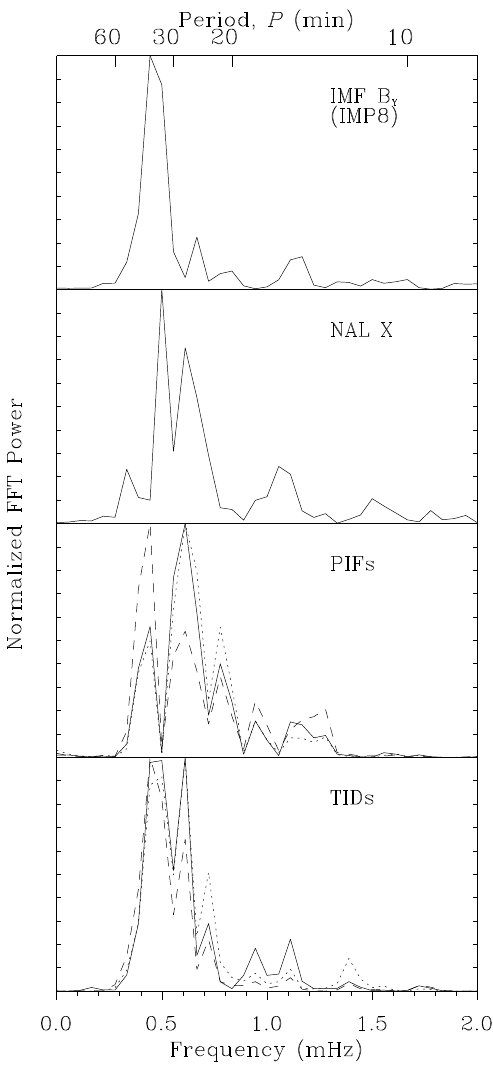
Fig. 13. Comparison of normalized spectra of the ground magnetic field X component, the IMF B y , the pure-state-filtered radar LOS velocity (PIFs) and ground-scatter power (TIDs). The two bottom panels show the spectral power for adjacent radar ranges as dotted, solid and dashed